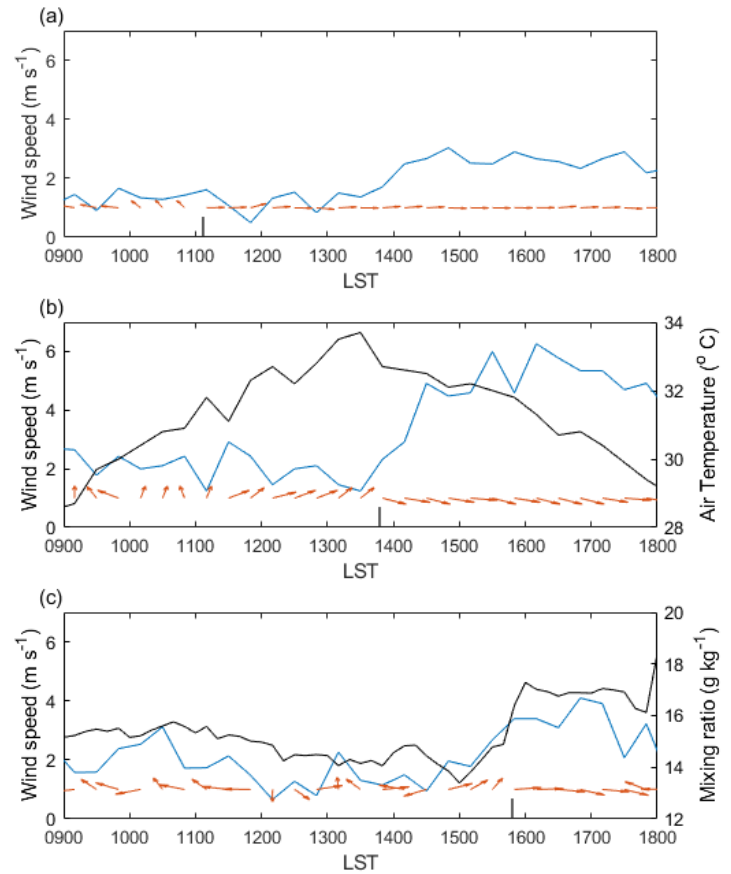
Figure 3. The time series of wind direction (arrow) and speed (blue line) for ( a ) Gongchondong, ( b ) Gimpo airport, and ( c ) Seoul station. The black line in ( b ) and ( c ) indicates air temperature and the mixing ratio, respectively. The black vertical line indicates the arrival time of the sea breeze front (SBF).